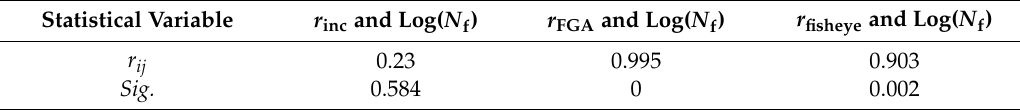
Table 1. The correlation coefficient between crack sizes and fatigue